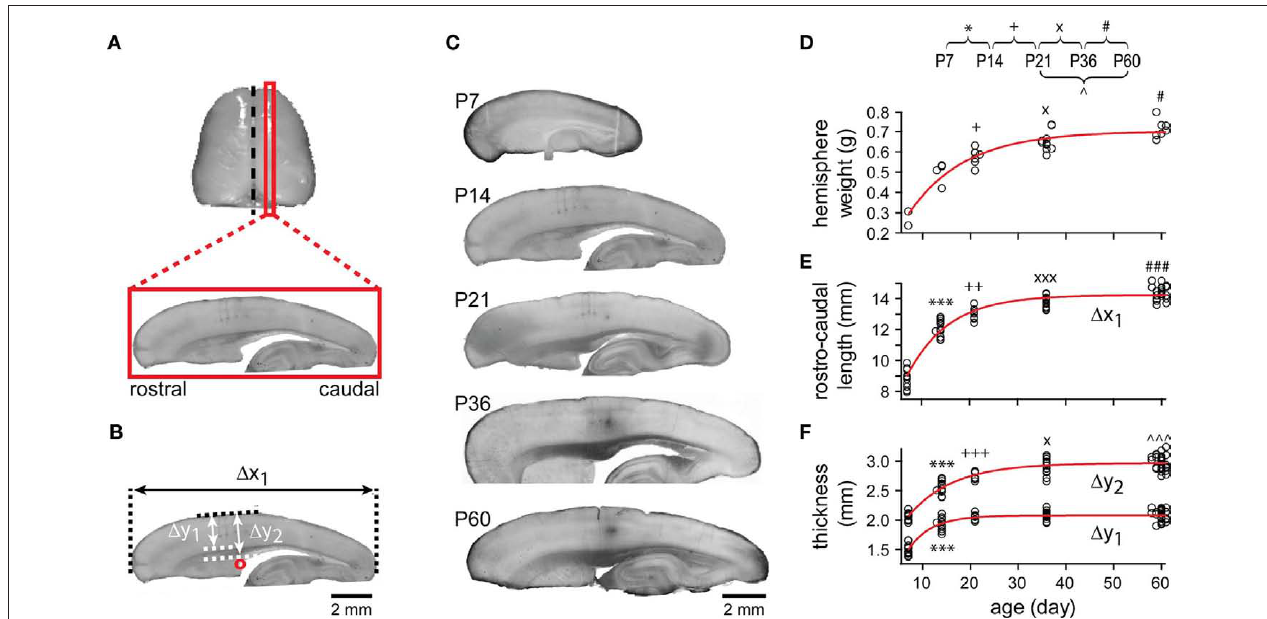
exponential line (red) of length constant (the time taken for each parameter to Figure 2 | gross anatomical development. (A) Typical sagittal slices were reach 63.2% of its final value from P7): 12.15 ± 2.03 days. For (e–F) , the same cut at the cortical region 1.5–2.4 mm from midline (black dashed line). (B) The conventions are shown as in (D) . (e) Rostro-caudal cortical length (P7: n = 11, rostro-caudal cortical length ( ∆ x ) was the maximal length of a section along 1 P14: n = 12, P21: n = 8, P36: n = 14, P60: n = 22). Length constant of the rostro-lateral axis. The neocortical thickness ( ∆ y ) was measured vertically 1 between pial and white matter, and the neocortical–callosal (neocortex + corpus callosum, ∆ y ) thickness was measured vertically from pial 2 to the level of superior rostral part of lateral ventricle (red circle). Scale bar, 2 mm. (C) Representative pictures of sagittal slices at different ages. Scale bar, 2 mm. (D) The weight of all individual cerebral hemispheres examined was plotted as a function of animal age (P7: n = 3, P13–P14, simplified as P14: n = 3, P21–P22, simplified as P21: n = 7, P35–P37, simplified as P36: n = 10, P59–P61, simplified as P60: n = 7). The points were fitted with a single